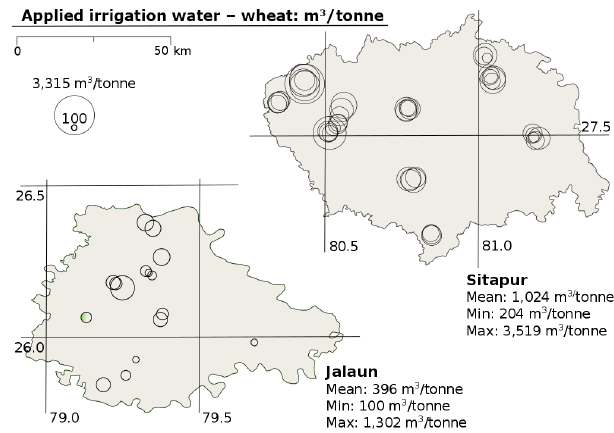
Figure 4. Spatial variations in the volume of water applied per tonne of wheat produced in Jalaun and Sitapur, Uttar Pradesh, northern